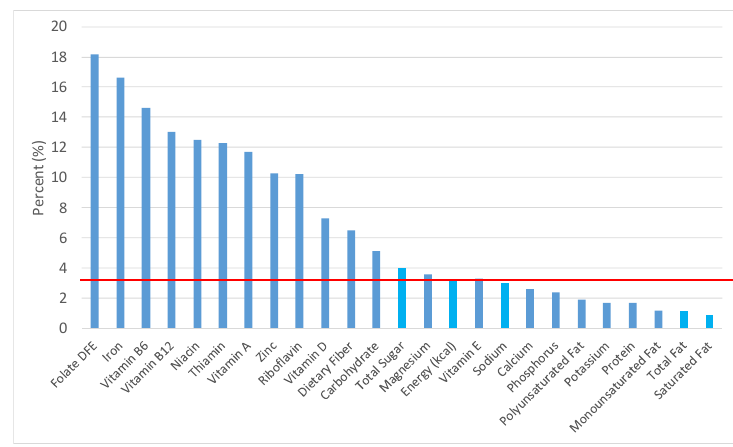
Figure 11. Ready-to-eat cereals as sources of energy and nutrients for children and adolescents Figure 11. Ready ‐ to ‐ eat cereals as sources of energy and nutrients for children and adolescents Figure 11. Ready ‐ to ‐ eat cereals as sources of energy and nutrients for children and adolescents Figure 11. Ready ‐ to ‐ eat cereals as sources of energy and nutrients for children and adolescents ( N = 6109, daily intake data): DFE = Dietary Folate Equivalents; solid red line represents percentage of ( N = 6109, daily intake data): DFE = Dietary Folate Equivalents; solid red line represents percentage ( N = 6109, daily intake data): DFE = Dietary Folate Equivalents; solid red line represents percentage ( N = 6109, daily intake data): DFE = Dietary Folate Equivalents; solid red line represents percentage energy (kcal) provided in the diet relative to nutrients—nutrients above the red line show the grain of energy (kcal) provided in the diet relative to nutrients—nutrients above the red line show the grain of energy (kcal) provided in the diet relative to nutrients—nutrients above the red line show the grain of energy (kcal) provided in the diet relative to nutrients—nutrients above the red line show the grain food’s contribution to nutrient density. food’s contribution to nutrient density. food’s contribution to nutrient density. food’s contribution to nutrient density.